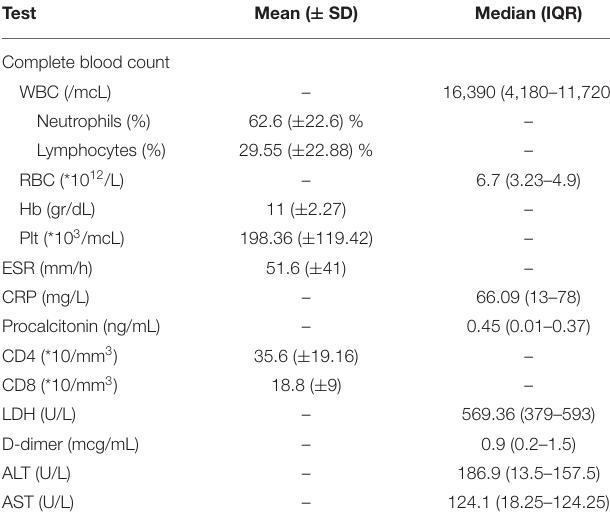
TABLE 2 | Laboratory results of the 15 patients with COVID19.